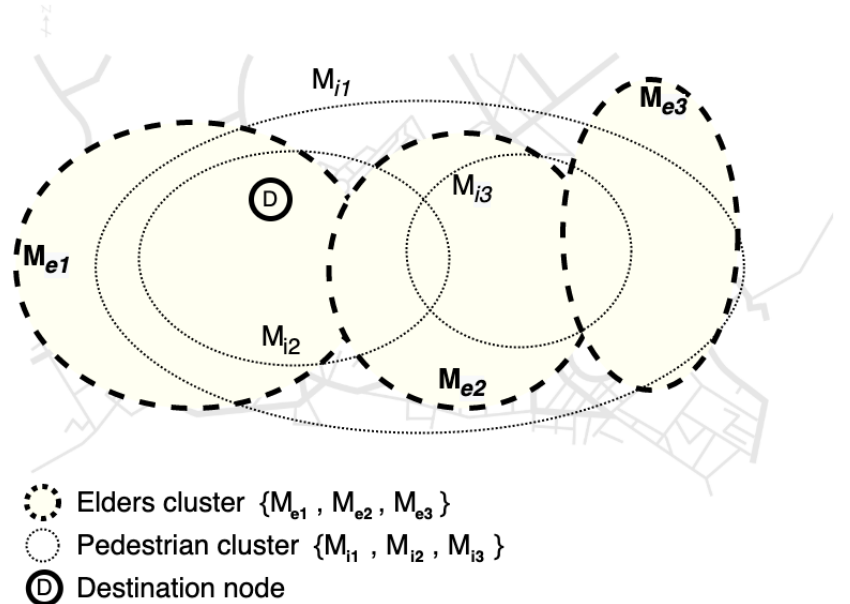
Figure 6. Mobility patterns ( M ) based on clusters in the simulated